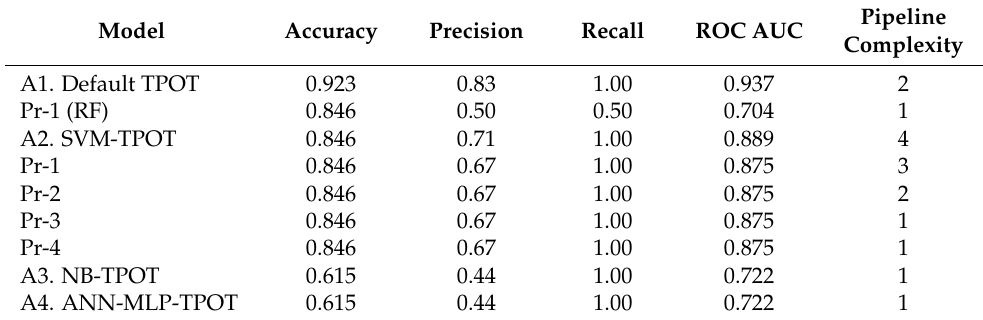
Table 6. The complexity–performance relationship for models selected by the TPOT optimization for each selected